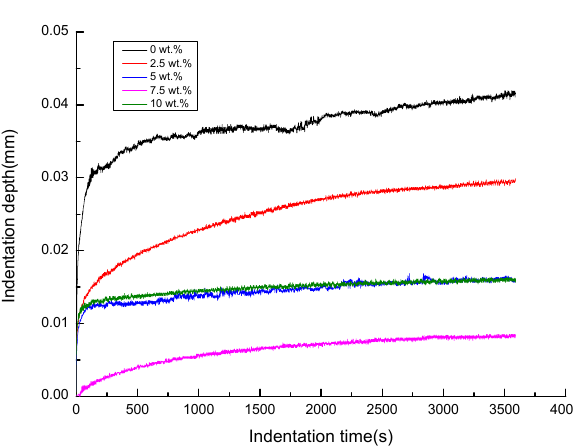
Figure 4: Variation in the compressive strength of the PEEK/SBF composites